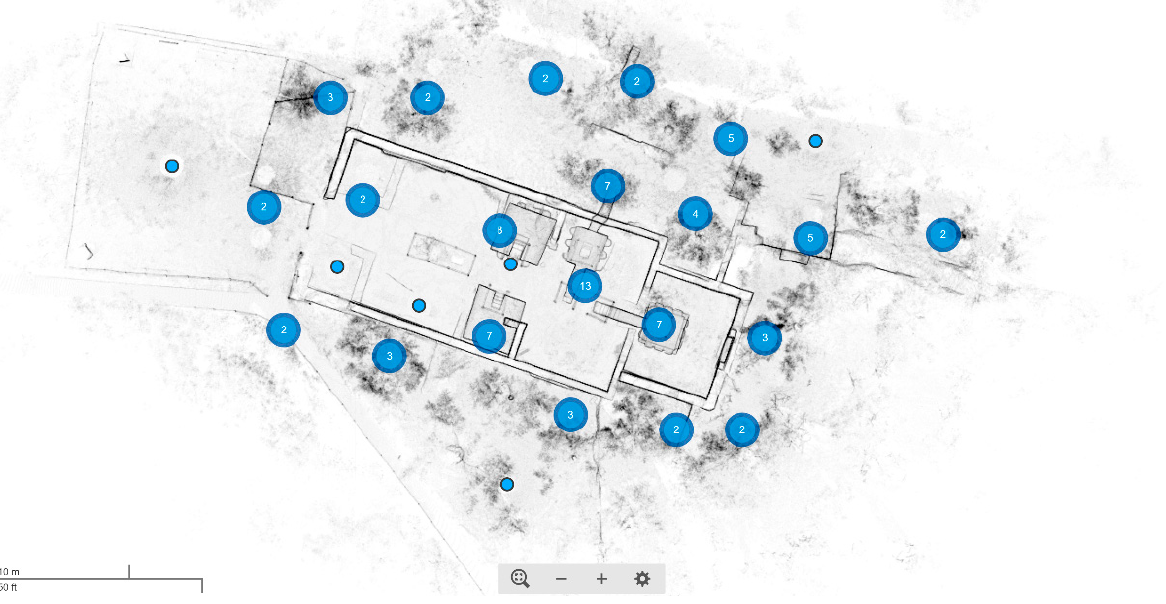
Figure 14. Panoramic map with blue marker cluster indicating scan location and (at the center) number of scans.